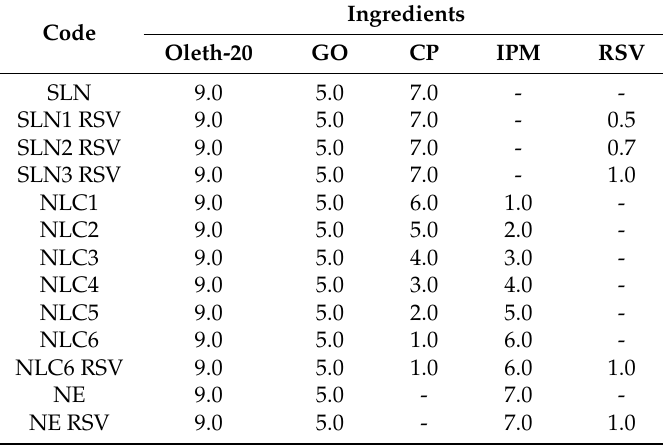
Table 1. Composition (% w / w ) of the lipophilic phase of unloaded and resveratrol (RSV) loaded